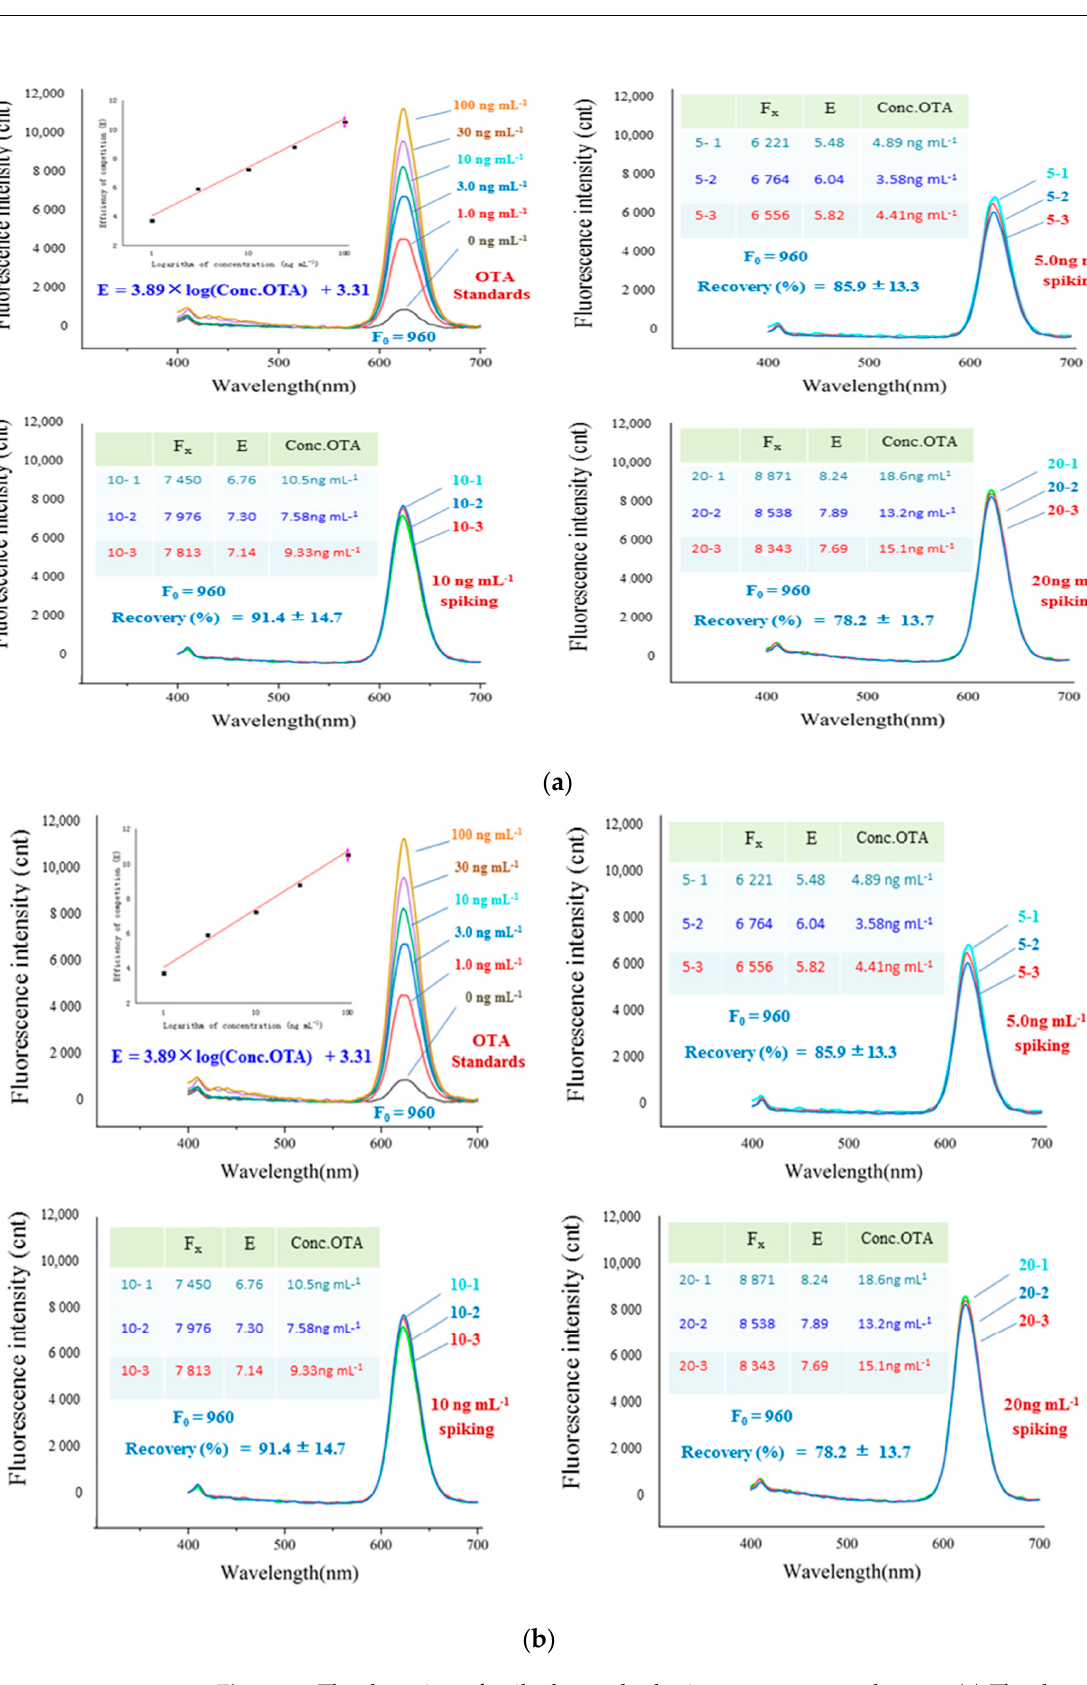
Figure 6. The detection of spiked samples by immuno-separated assay. ( a ) The detection of rice samples spiked with OTA. ( b ) The detection of beer samples spiked with OTA.